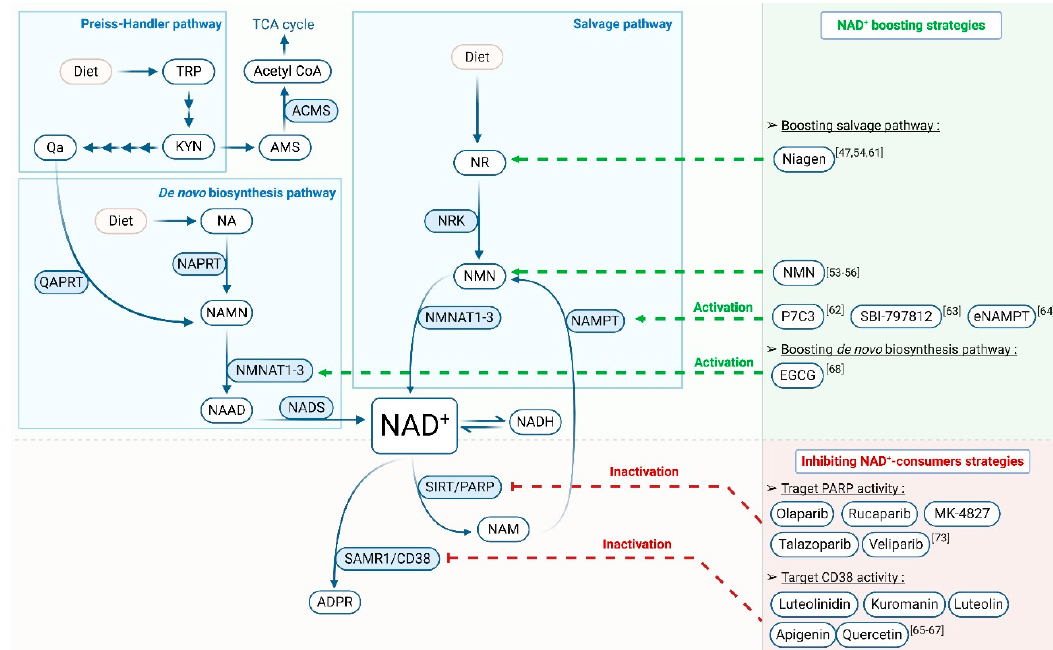
Figure 2. Clinical perspectives targeting altered nicotinamide adenine dinucleotide (NAD + ) metabolism to treat striated muscle laminopathies: strategies allowing a raise in NAD + synthesis or inhibiting its consumption have already proven their effects on NAD + levels. Future studies may